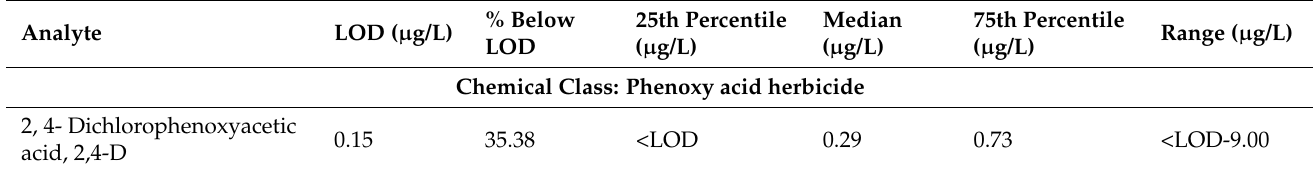
Table A2. Descriptive statistics of pesticide